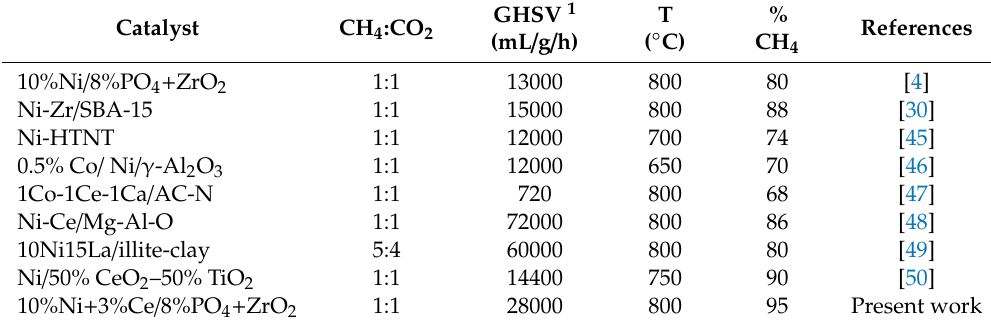
Table 4. Comparison between the CH 4 conversion acquired and those in the literature using di ff erent catalysts for the dry reforming of CH 4